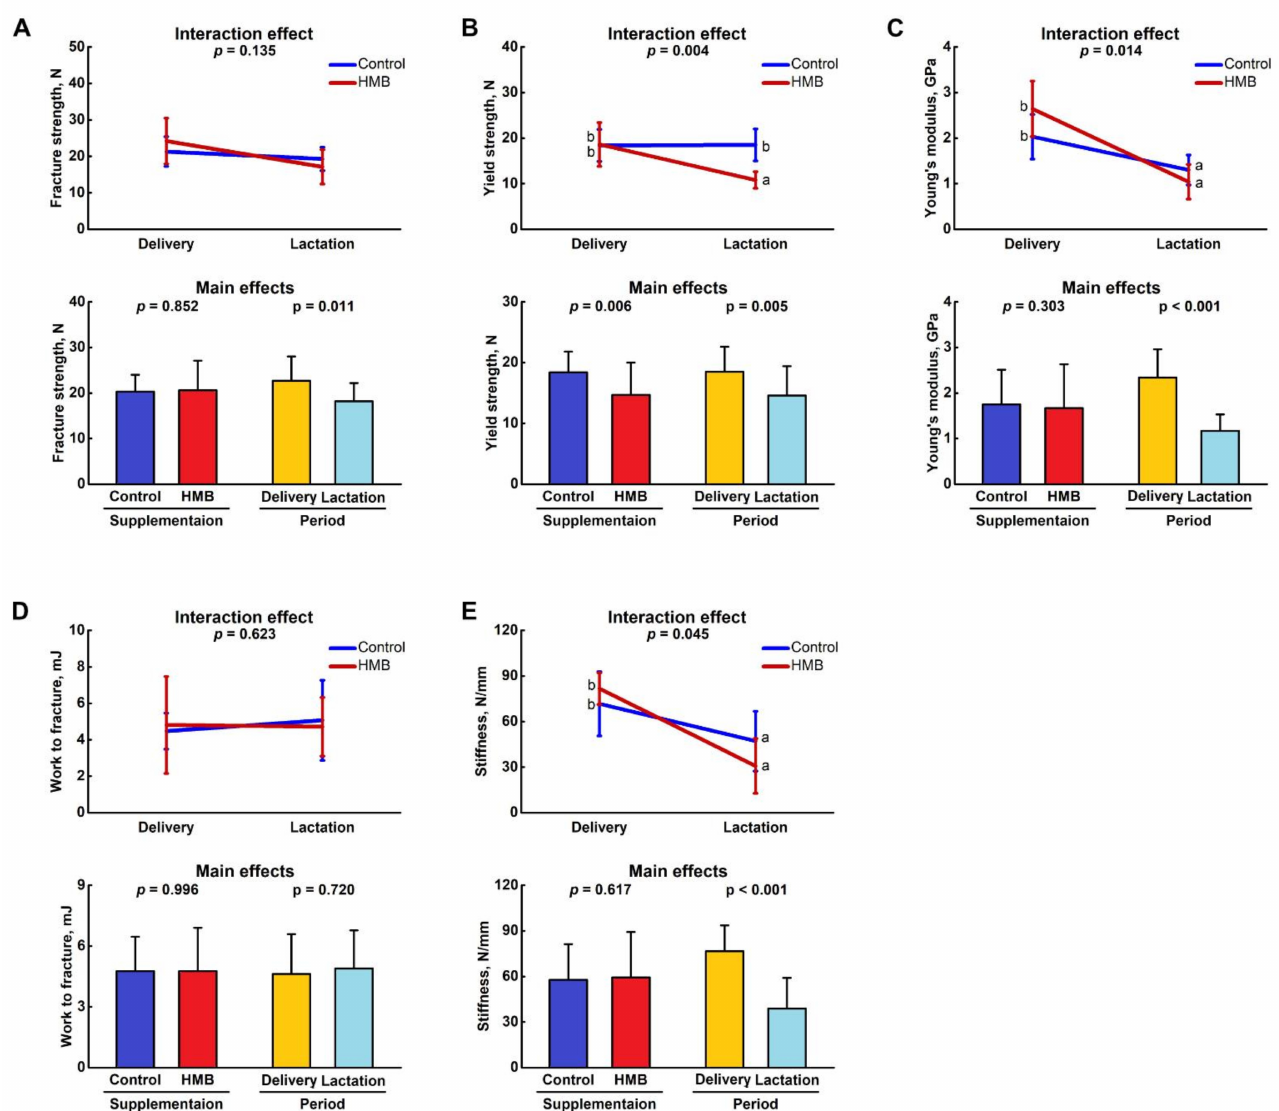
Figure 3. Effect of HMB supplementation (0.02 g/kg b.w.) during the middle trimester of pregnancy (13–26 d) on ( A ) fracture strength, ( B ) yield strength, ( C ) Young’s modulus, ( D ) work to fracture and ( E ) stiffness of femora of spiny mice at delivery or after the lactation period. Figure shows LSMeans ± standard deviation as well as p -values of a two-way ANOVA with the supplementation (control, HMB) and period (delivery, lactation) and their interaction as fixed effects. Means with different letters in interaction effect plots differ significantly (Tukey’s post-hoc